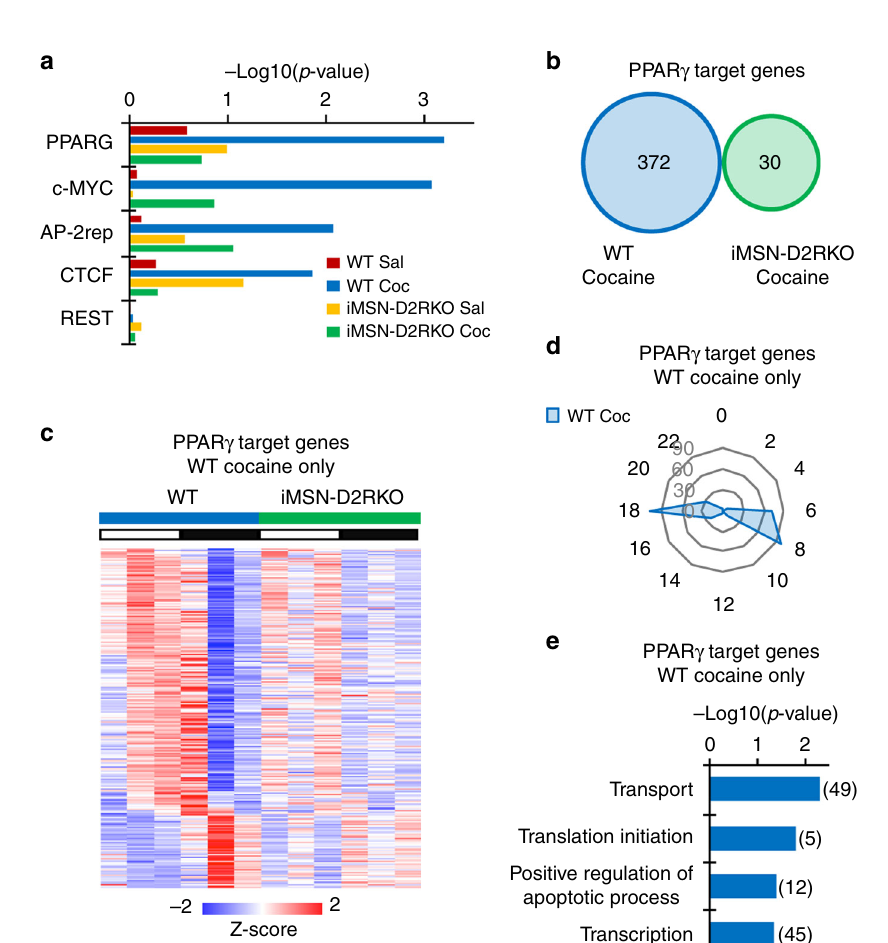
Fig. 3 D2R ablation from iMSN reorganizes the striatal circadian transcriptome. a Venn diagram of striatal oscillating genes in saline treated WT and iMSN-D2RKO mice ( n = 3, JTK_Cycle, cutoff p < 0.01). b Radar plots displaying the phase analysis of genes whose expression is exclusively circadian in WT mice (left) or in iMSN-D2RKO saline-treated (Sal) mice (right). c Heat maps of genes signi fi cantly circadian ( n = 3, JTK_Cycle, cutoff p < 0.01) only in WT (left) or in iMSN-D2RKO (right) saline-treated mice. White and black bars indicate the light (ZT3, 7, 11) and dark (ZT15, 19, 23) timepoints respectively. d DAVID Gene Ontology Biological Process analysis of circadian genes oscillating in saline WT only (left) and in saline iMSN-D2RKO only (right). Bar charts represent the -Log10( p -value) of each enriched term. The number of genes identi fi ed in each pathway is shown in parenthesis. e Venn diagram of striatal oscillating genes in cocaine treated WT and iMSN-D2RKO mice ( n = 3, JTK_Cycle, cutoff p < 0.01). f Radar plots displaying the phase analysis of genes whose expression is exclusively circadian in WT (left) or in iMSN-D2RKO cocaine-treated (Coc) mice (right). g Heat maps of genes signi fi cantly circadian ( n = 3, JTK_Cycle, cutoff p < 0.01) only in WT (left) or in iMSN-D2RKO (right) cocaine-treated mice. White and black bars indicate the light (ZT3, 7, 11) and dark (ZT15, 19, 23) timepoints respectively. h DAVID Gene Ontology Biological Process analysis of circadian genes oscillating in cocaine WT only or in cocaine iMSN-D2RKO only. Bar charts represent the -Log10( p -value) of each enriched term. The number of genes identi fi ed in each pathway is shown in parenthesis.